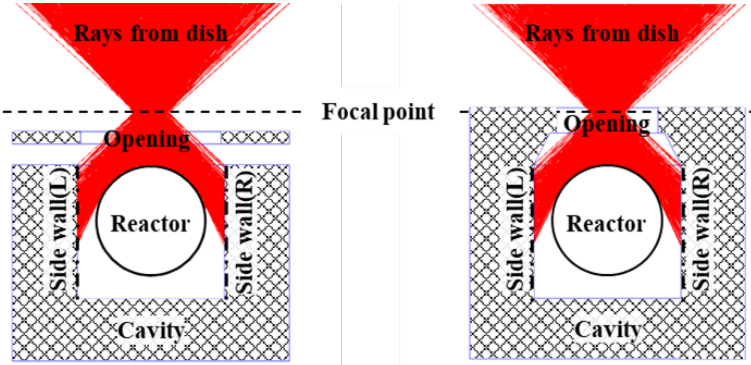
Figure 13. Sun ray distributions in semi-cavity ( left ) and full cavity ( right ).